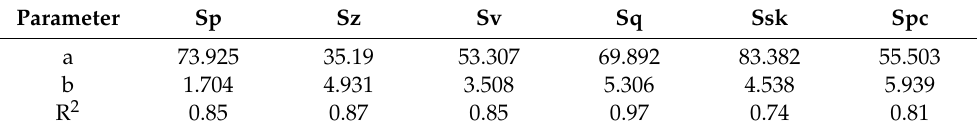
Table 11. Fitting parameters of initial 3D texture parameters of pavement and British